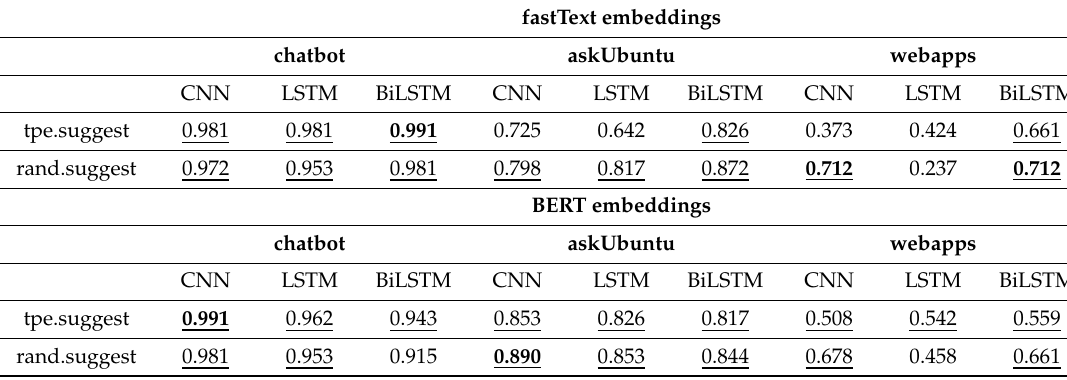
Table 5. Evaluated accuracies on the English testing datasets with optimized models. The best accuracy values are in bold; values not statistically significant, di ff ering from the best, are underlined.